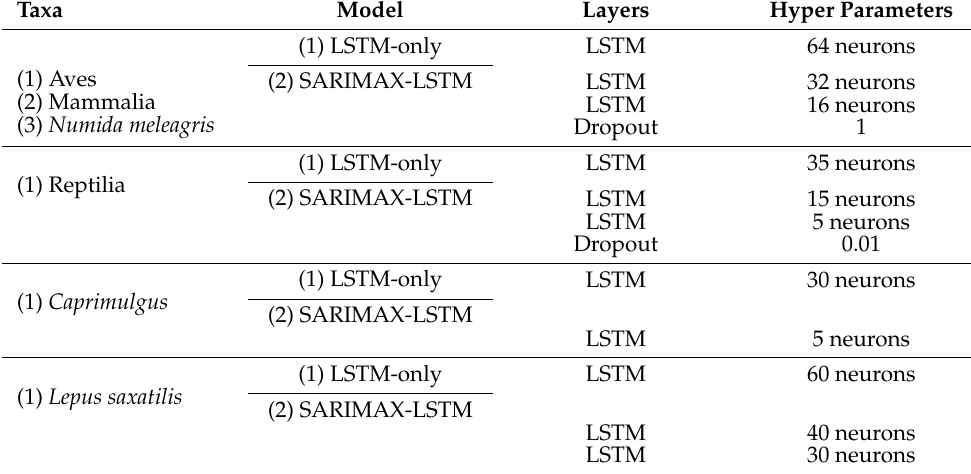
Table 7. Model architectures for LSTM-only and SARIMAX-LSTM for each model and associated taxa as well as the datasets. Each dataset used a learning rate scheduler with an initial learning rate of 1 × 10 − 2 , a dense output layer of 1 unit, an Adam optimizer, and a sigmoid activation function. The models show the number of layers used and the hyperparameters. Taxa Model Layers Hyper